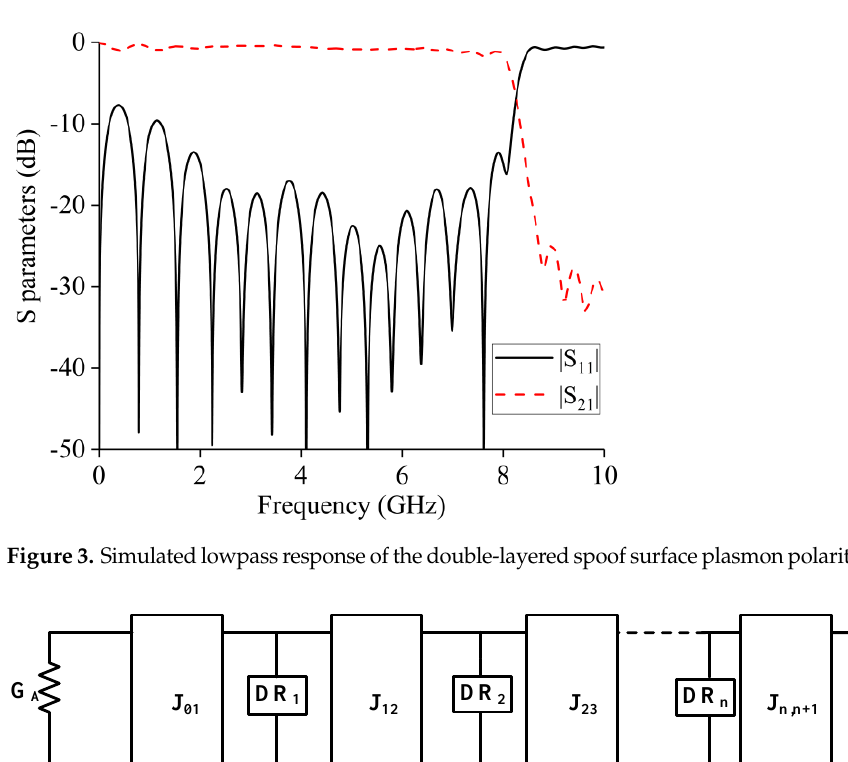
Figure 4. Topology structure of the passband filter.